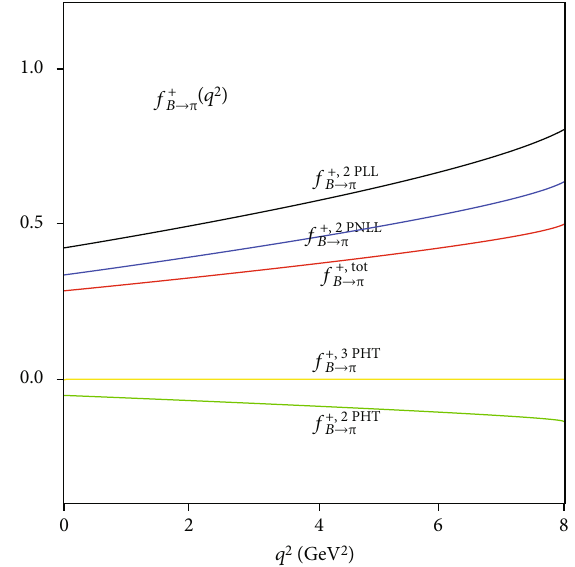
ð q 2 Þ . The red B ⟶ π